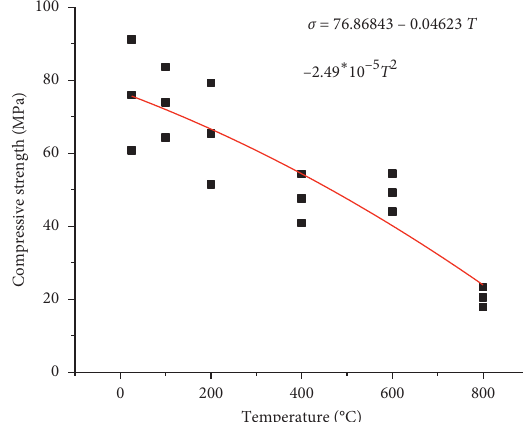
Figure 9: The strength-temperature curve for uniaxial compressive strength